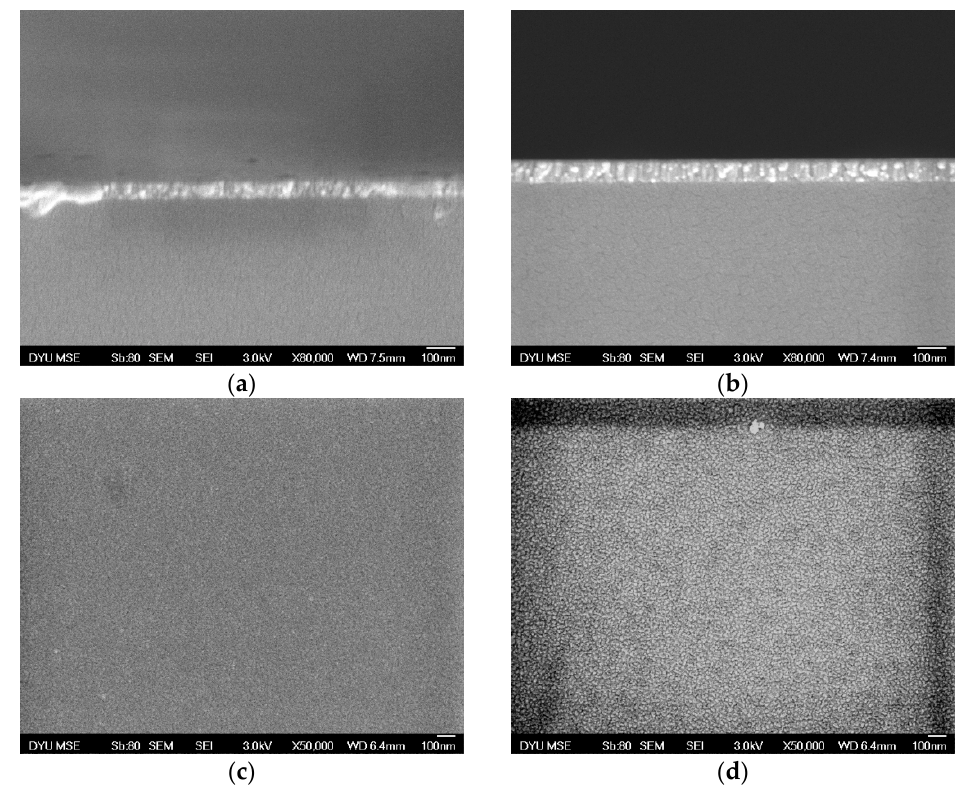
Figure 2. Cross-sectional SEM images of CoFeW 50 nm. ( a ) RT and ( b ) annealed at 350 °C. SEM micrographs of CoFeW 50 nm. ( c ) RT and ( d ) annealed at 350 °C.